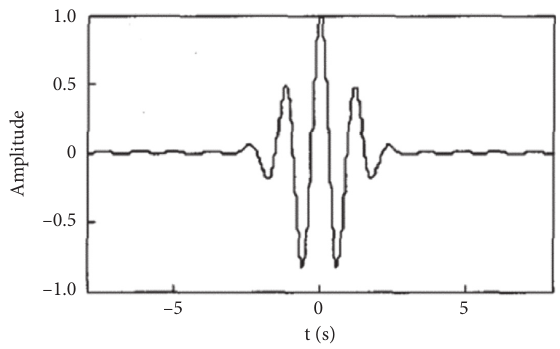
Figure 13: Waveform of the Morlet